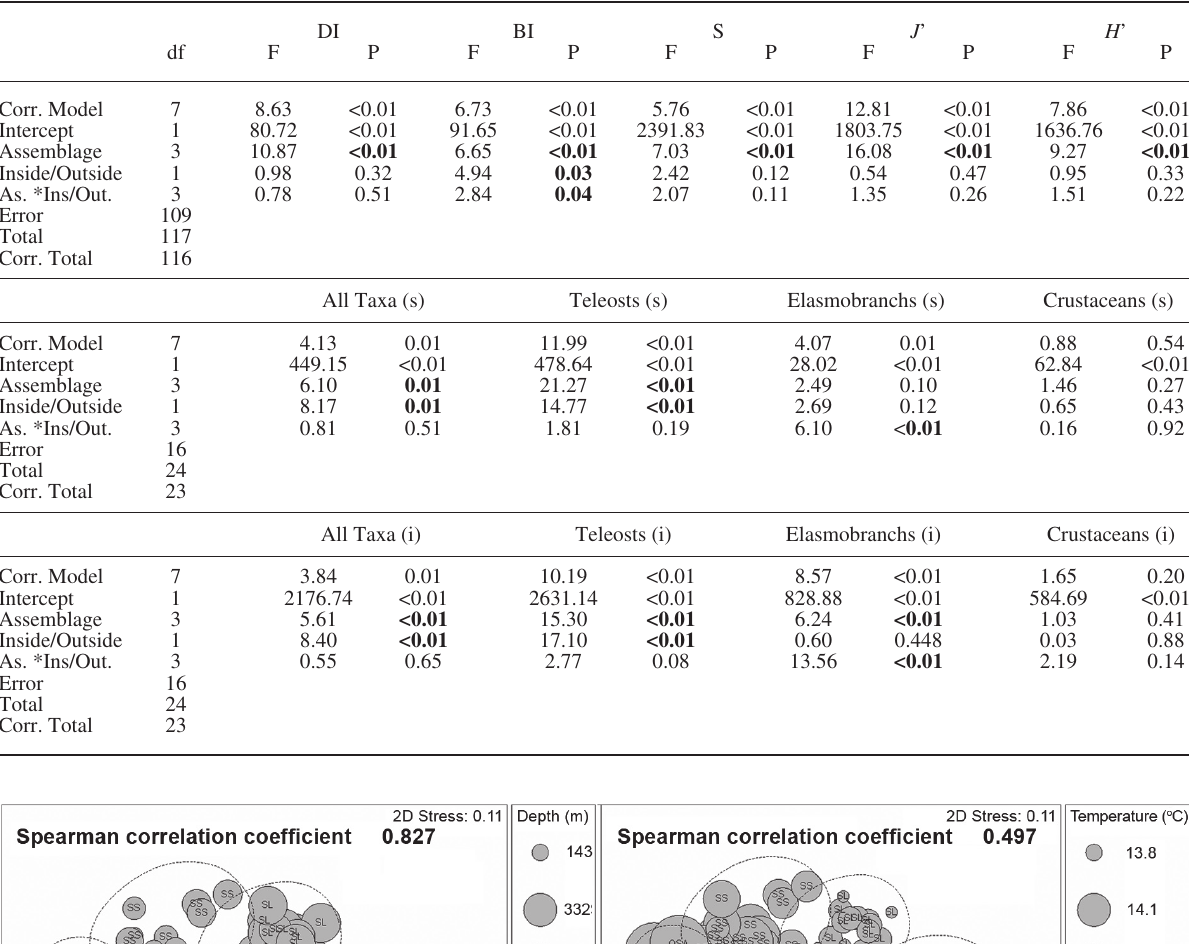
Table 3. – Summary of the outcome of the 2-Way GLM ANOVA for the effects of assemblages and inside/outside the 25 nautical mile FMZ and the interaction between these factors (see Figs. 3 and 5) for Density Index (DI) in N/km 2 , mean Biomass Index (BI) in kg/km 2 , mean number of species (S), mean Shannon-Weiner diversity ( H’ ) and mean Pielou`s evenness ( J’ ) and slopes (s) and intercepts (i) of the biomass size spectra. The characters in bold show a significant differences at P < 0.05.